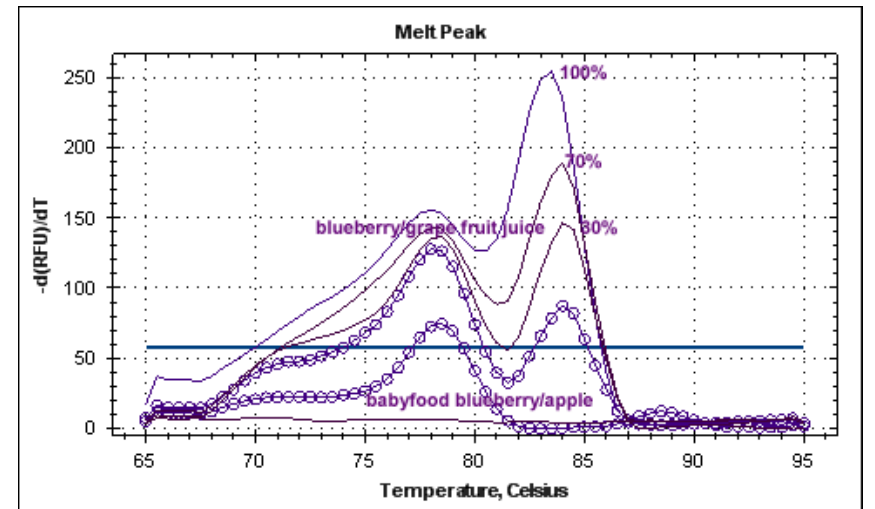
Figure 5. Melting peak profiles of real-time PCR carried out with blueberry juice at different percentages and blueberry-based foods with the new species-specific primer